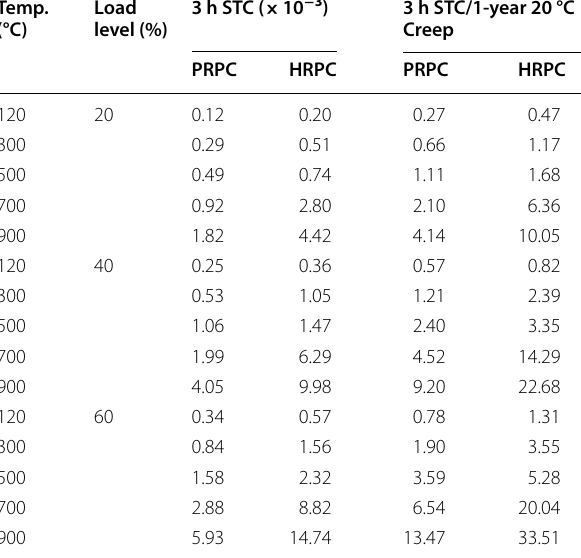
Table 7 STC of RPC and its ratio to 1-year ambient temperature creep of